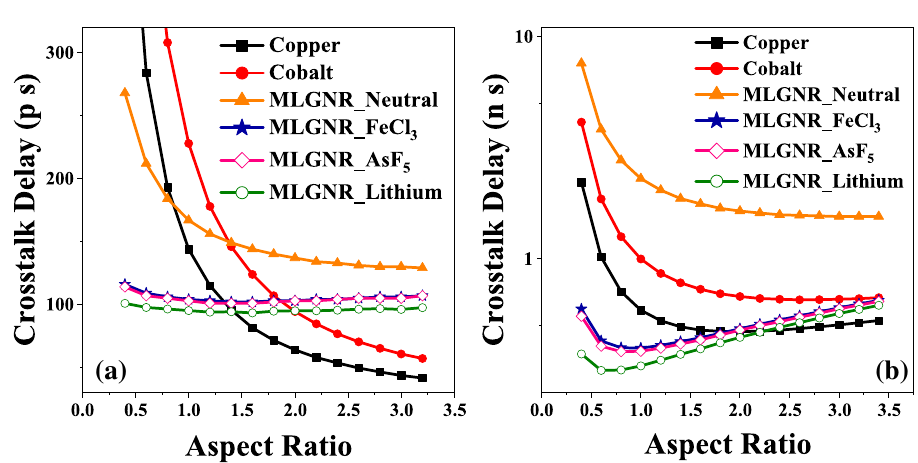
Figure 4. Optimized AR at minimum crosstalk induced delay in ( a ) intermediate level (L = 10 µ m) and ( b ) global level (L = 1 mm)